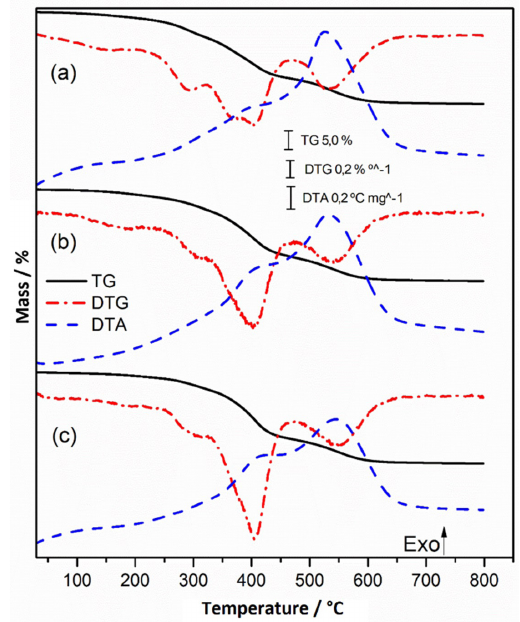
Figure 2. TG/DTG-DTA curves for the monomeric mixture (a), P-Halogen (b), P-LED